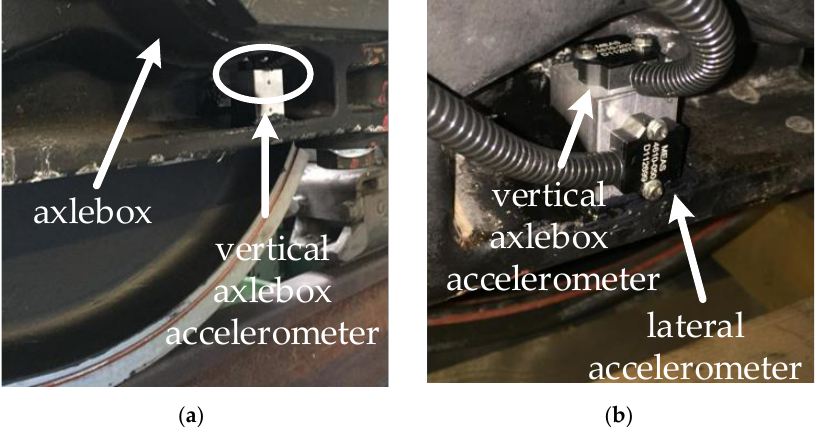
Figure 1. Accelerometers mounted on the axlebox of a wheelset of the instrumented trailer bogie (the same setup is repeated on the other wheelset): ( a ) side A, vertical axlebox accelerometer; ( b ) side B, vertical and lateral axlebox accelerometers.